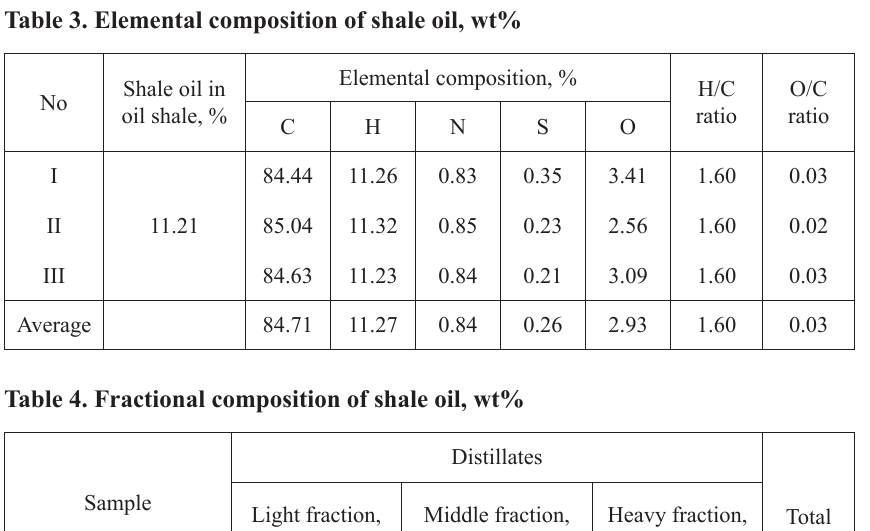
Table 3. Elemental composition of shale oil, wt%